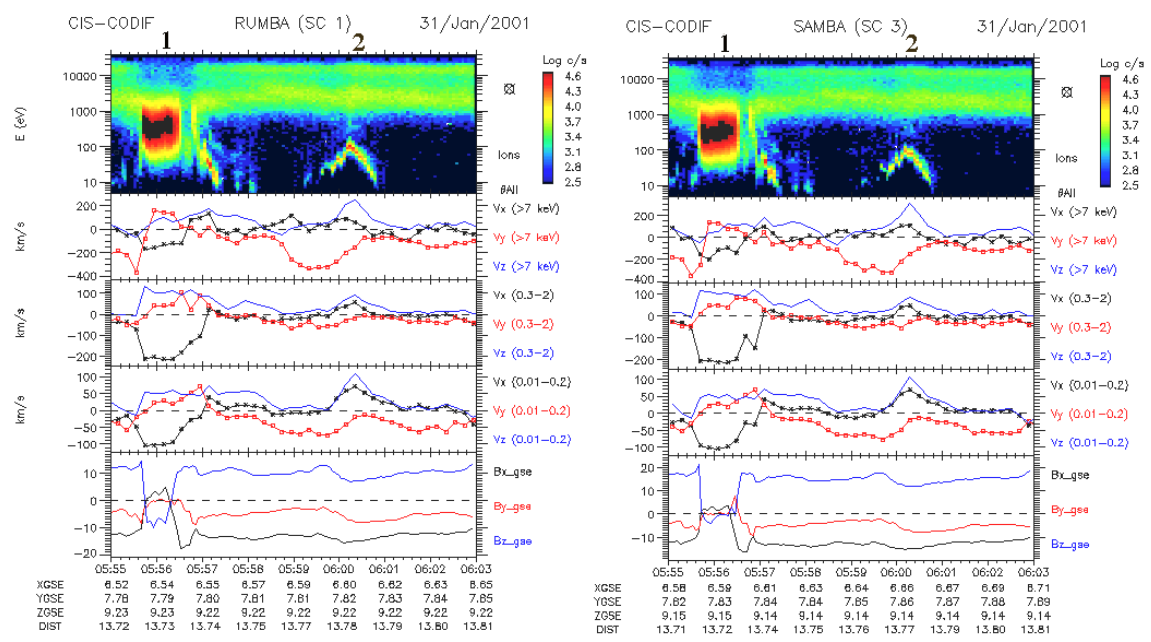
Fig. 3. Encounter of magnetosheath-like plasma on 31 January 2001, when the IMF was directed southward ( − 2nT). This encounter is also described by Sauvaud et al. (2001). The first event (1) is dominated by magnetosheath plasma while the second (2) lacks such a